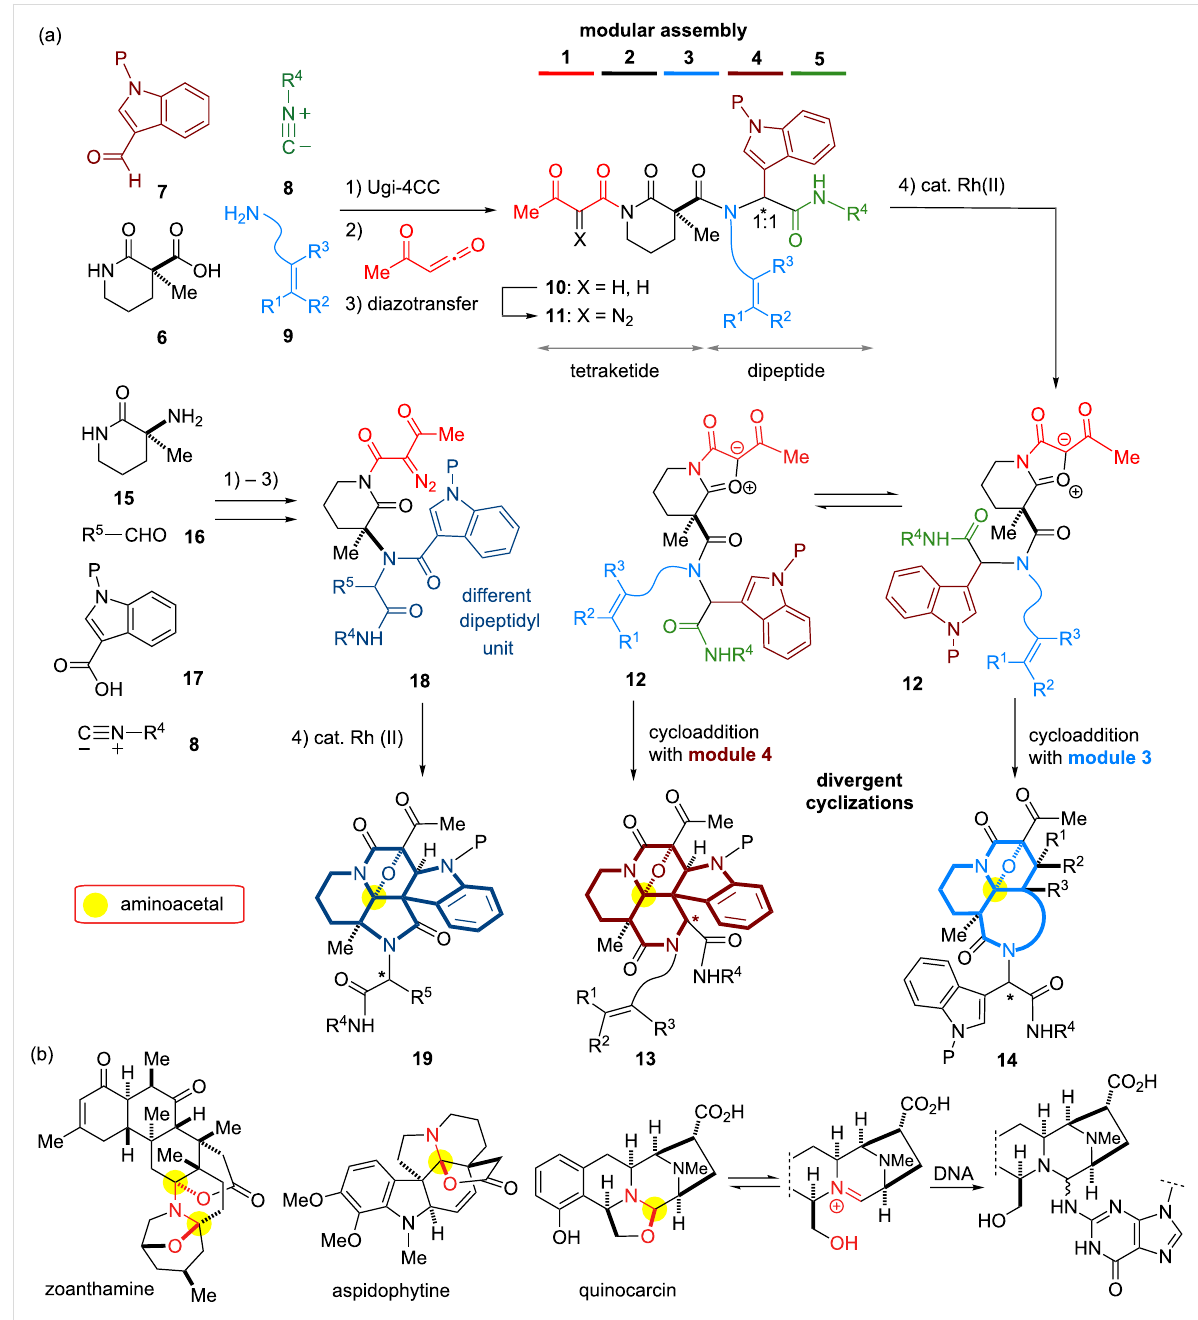
Figure 2: (a) Synthetic plans based on modular assembly and divergent cyclizations leading to fused skeletons; (b) structures of naturally occurring alkaloids bearing aminoacetal moieties and a proposed mode of action of quinocarcin.